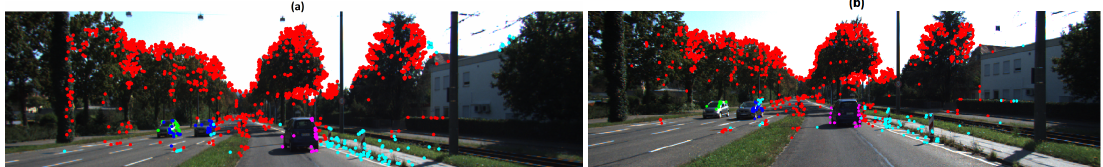
Figure 21. TbD-SfM results for Scene 5: ( a ) 1th frame segmentation; ( b ) 4th frame